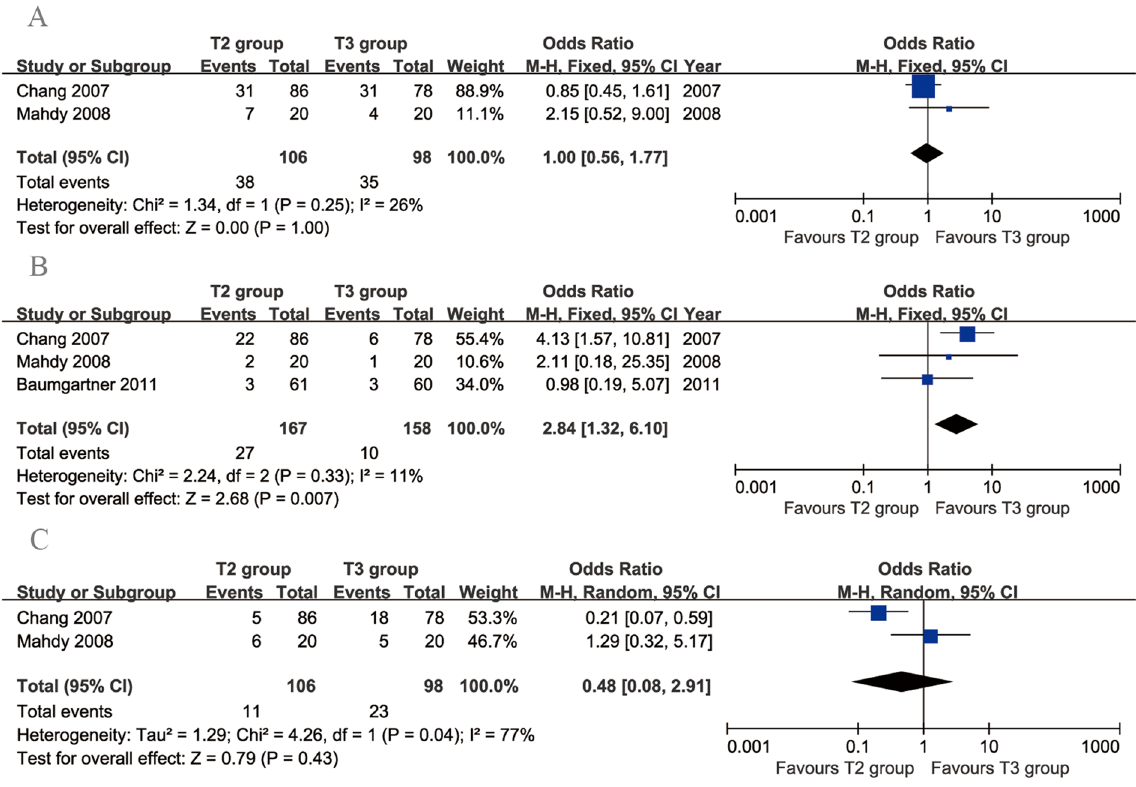
Figure 4. Forest plots for other postoperative complications in the T2 and T3 groups. ( A ) Recurrence, ( B ) dry hands and ( C ) gustatory sweating.